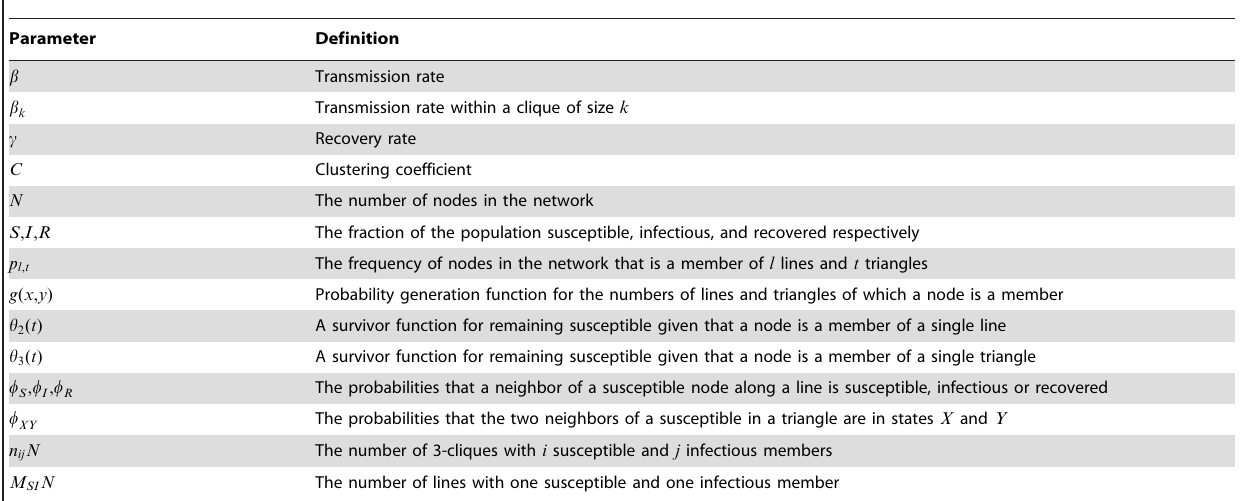
Table 1. Definitions for key parameters and